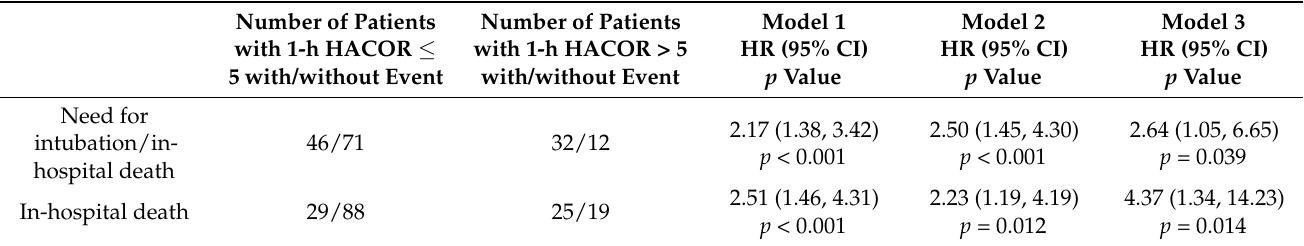
Table 4. Association between high HACOR score measured 1 h after the start of NIRS treatment, the composite endpoint (need for intubation/in-hospital death), and in-hospital